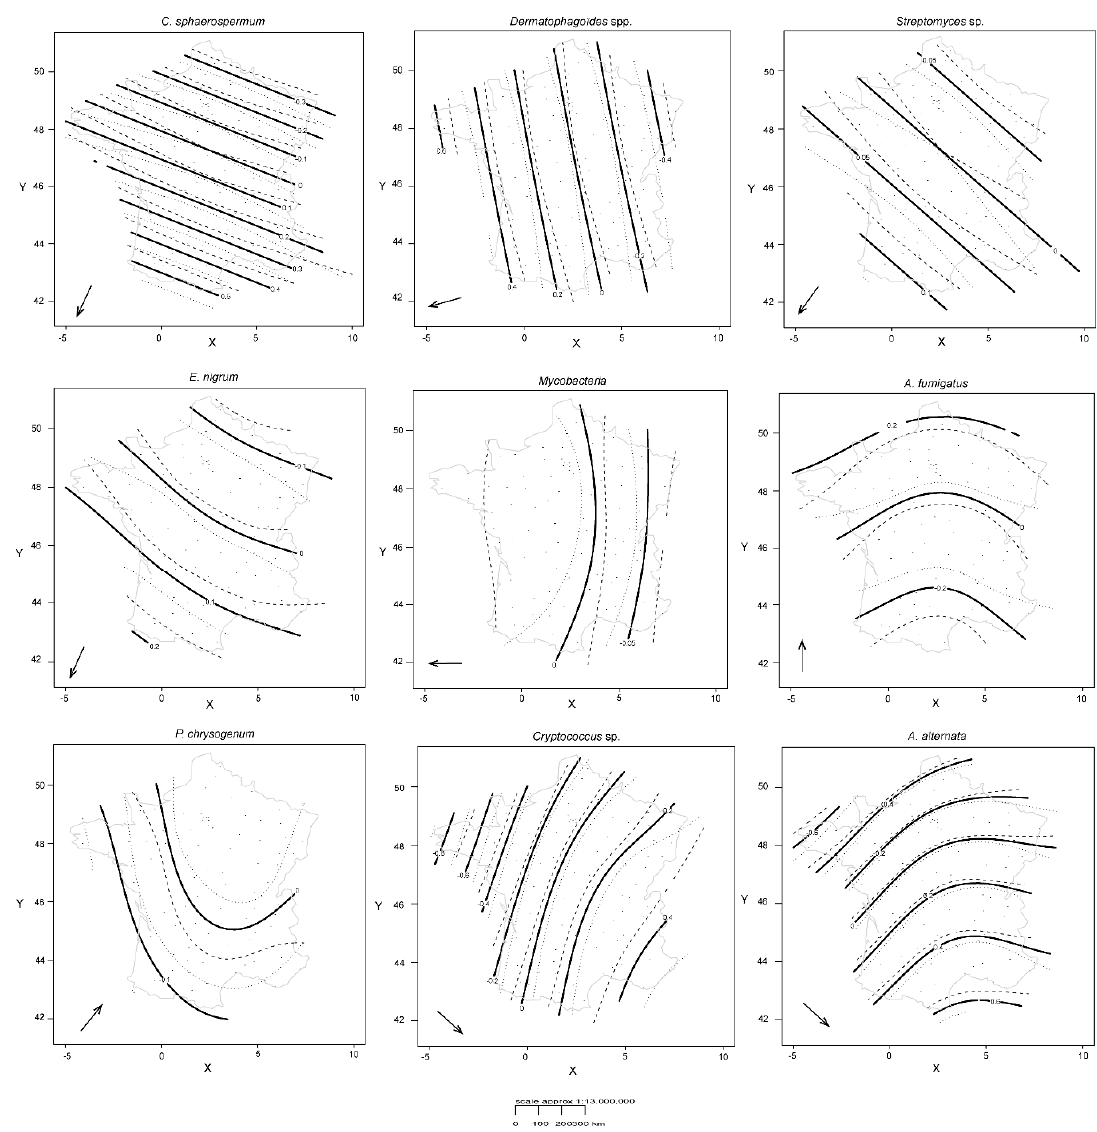
Figure 2. Spatial patterns for log-transformed copy number of qPCR targets for nine microorganisms exhibiting significant spatial variability. As Dermatophagoïdes spp. and D. pteronyssinus targets showed the same distributions, only one of the two is represented. Solid lines represent smoother contours (smoothing component f(Xi,Yi), with X: longitude and Y: latitude) and the dotted lines are 95% confidence bands. Arrows indicate the direction of the abundance gradient from lower to higher abundances. Table 3. Detailed output on the smoothers and parametric terms in the Generalized additive mixed models (GAMMs).